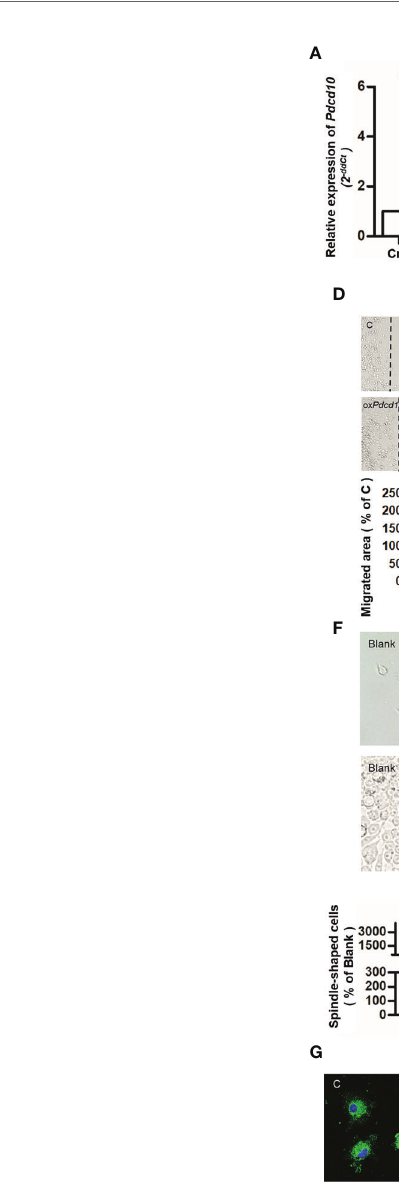
FIGURE 3 | Overexpression of Pdcd10 in murine GBM cells activated microglia and macrophages in vitro . (A, B) Stable upregulation of Pdcd10 in murine GBM cell line GL261 (ox Pdcd10 ) was established by the transduction of lentivirus vector. The control cells (Cm) were transducted with empty vector. The PDCD10 upregulation was con fi rmed at mRNA (A) and protein levers (B) . The murine microglia-like cell line (BV2), macrophage-like cell line (RAW264.7) and primary microglia (microglia) were used in the following experiments. (C) Medium derived from ox Pdcd10 -GL261 cells (CM) promoted cell proliferation in BV2 and RAW264.7 cells. Cell proliferation was detected by CCK-8 assay. (D, E) CM activated cell migration in BV2 and RAW264.7 cells. For scratch assay (D) , BV2 and RAW264.7 cells was seeded in a 6-well-plate followed by media replacement with CM and control medium (C) retrospectively. 48 hours after scratching, the migrated area was automatic calculated by image J software. The transwell assay (E) was performed using BV2 and RAW264.7 cells. Cells were suspended with serum-free media and seeded into upper insert. CM or control medium was added into the lower chamber. (F) The morphological features of primary microglia and RAW264.7 cells. Primary microglia mostly displayed a round-shaped morphology with short cellular processes (left panel). Both CM and control medium induced a spindle-shaped morphologic transformation in both primary microglia and RAW264.7 cells (middle and right panel). In particular, signi fi cantly more spindle-shaped cells and longer cellular processes (arrowheads) were identi fi ed in both primary microglia and RAW264.7 cells incubated with CM. (G). Immuno fl uorescent staining of Iba1 in microglia showing morphological change induced by CM treatment More spindle-shape microglia were observed in CM-treated group. Scar bar = 20 m m. (H) CM induced phenotype polarization in primary microglia, BV2 and RAW264.7 cells. Various gene expressions were detected by RT 2 -PCR and showed in a heat-map (black box indicated statistic difference). ++ p <0.01 and +++ p < 0.001, compared with Cm; **p < 0.01 and ***p < 0.001, compared with C; ### p < 0.001, compared with